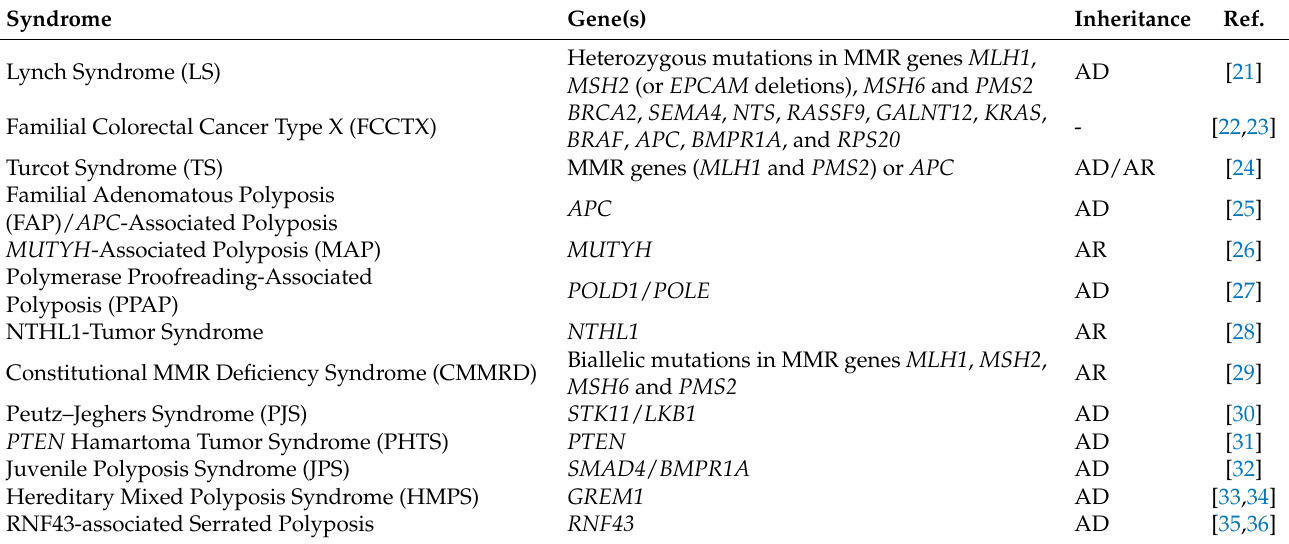
Table 1. Classification and genetic causes of hereditary CRC